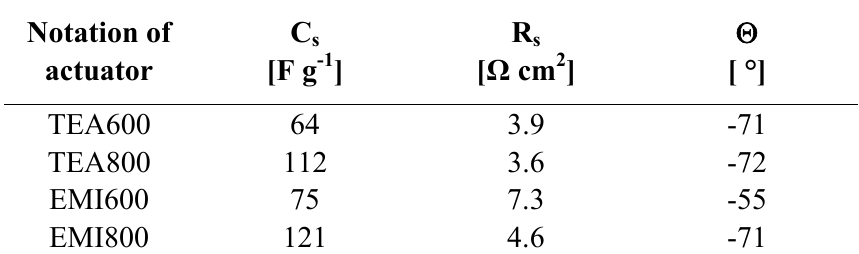
Table 3. The series capacitance (C from EIS